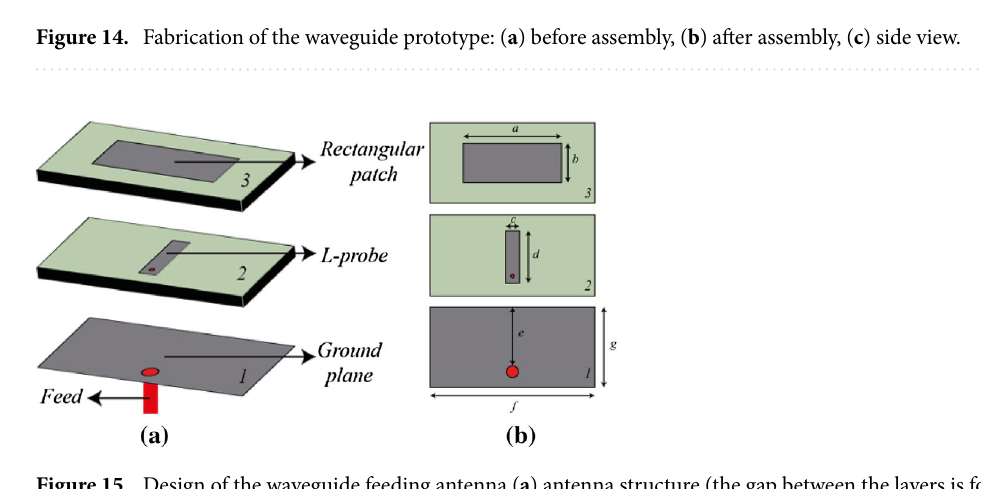
Figure 15. Design of the waveguide feeding antenna ( a ) antenna structure (the gap between the layers is for illustration purpose only, layers 1, 2 and 3 are stacked without any gap in between), ( b ) parameters: a = 28, b = 11.2, c = 4, d = 15, e = 16.8, f = 47, g =